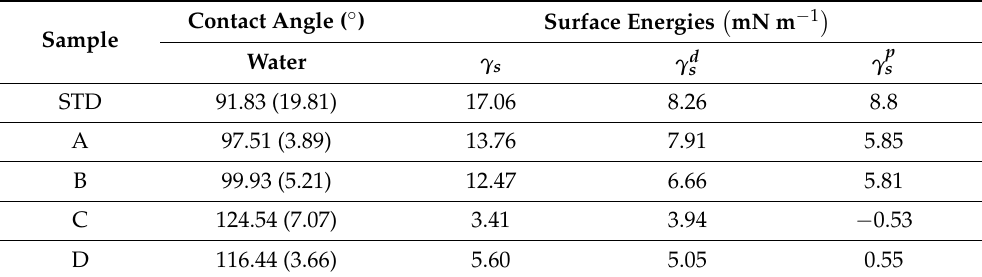
Figure 10. Wetting angle and its variation as a function of time of the ( ⚫ ) standard foam, ( ) foam A, ( ) foam B, ( ) foam C, and ( ◼ ) foam D. Table 6. Contact angle measurement and value of total surface free energy